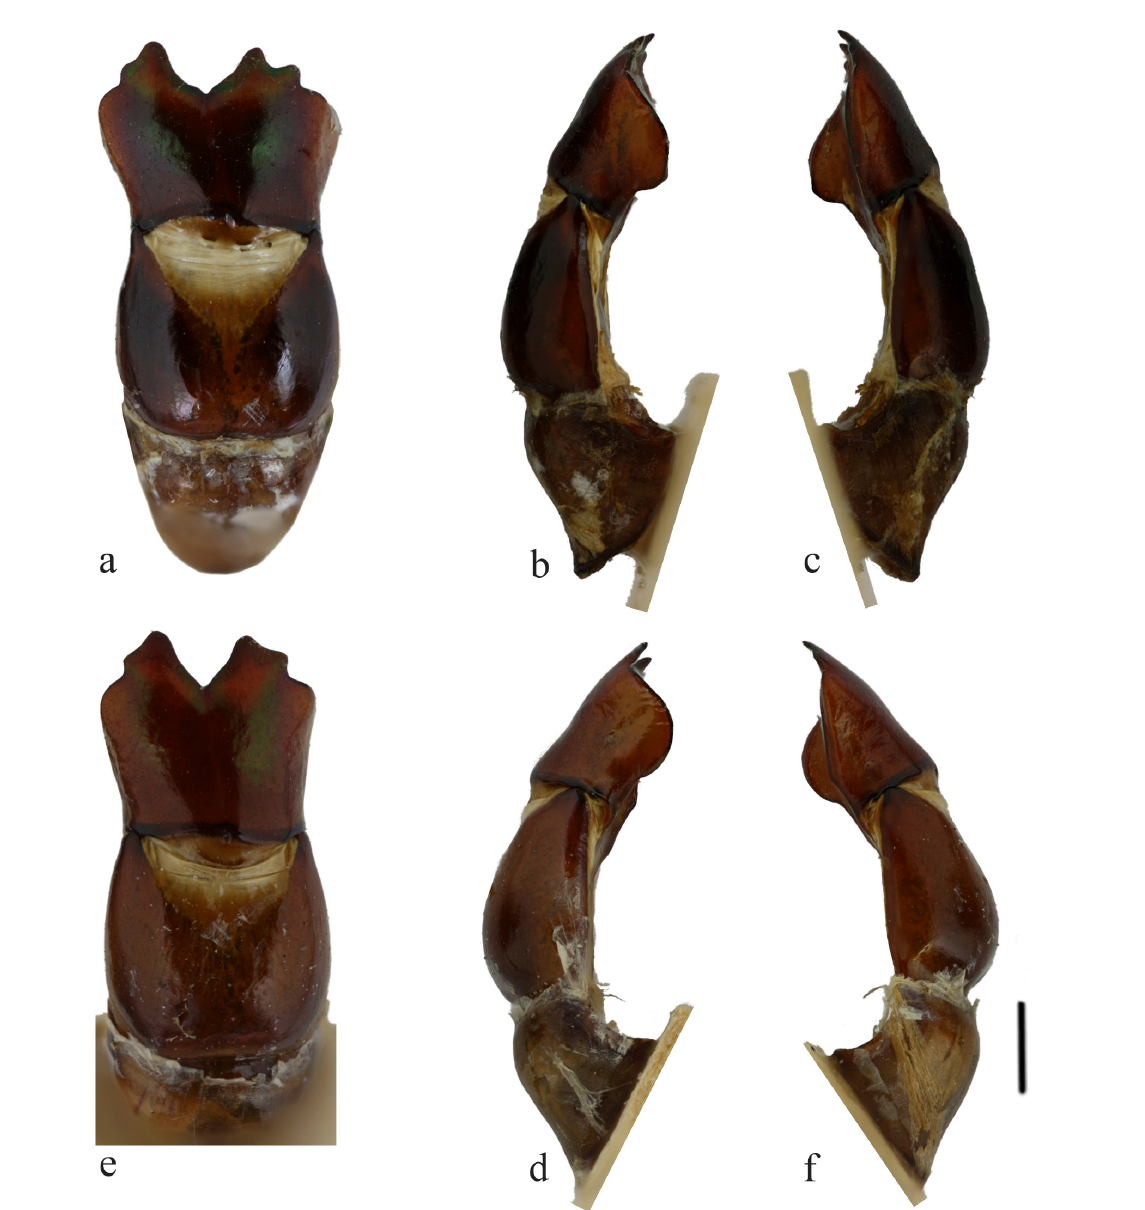
Fig. 6. Aedeagus in dorsal (a, e) and lateral view (b–c, d–f). a–c . Oplognathus helmenreichi Ohaus, 1905, holotype, ♂ (ZMHB). d–f . O. helmenreichi var. maculicollis Ohaus, 1914, syntype, ♂ (ZMHB). Scale bar = 1